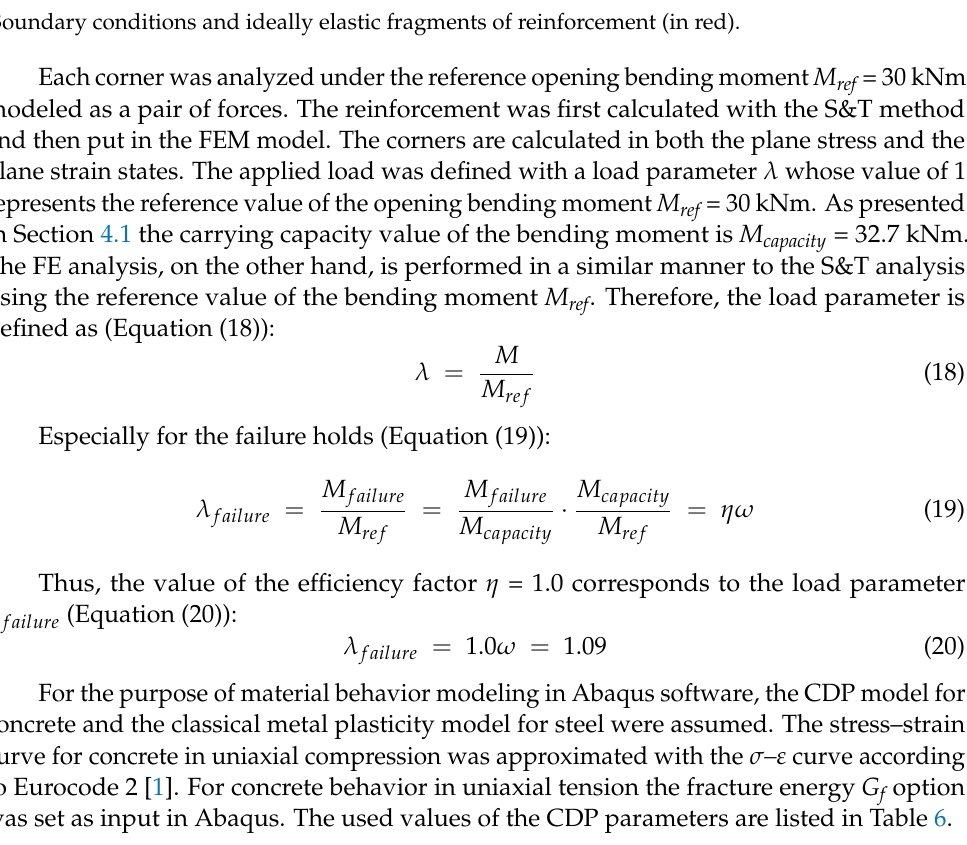
Figure 19. Boundary conditions and ideally elastic fragments of reinforcement (in red).